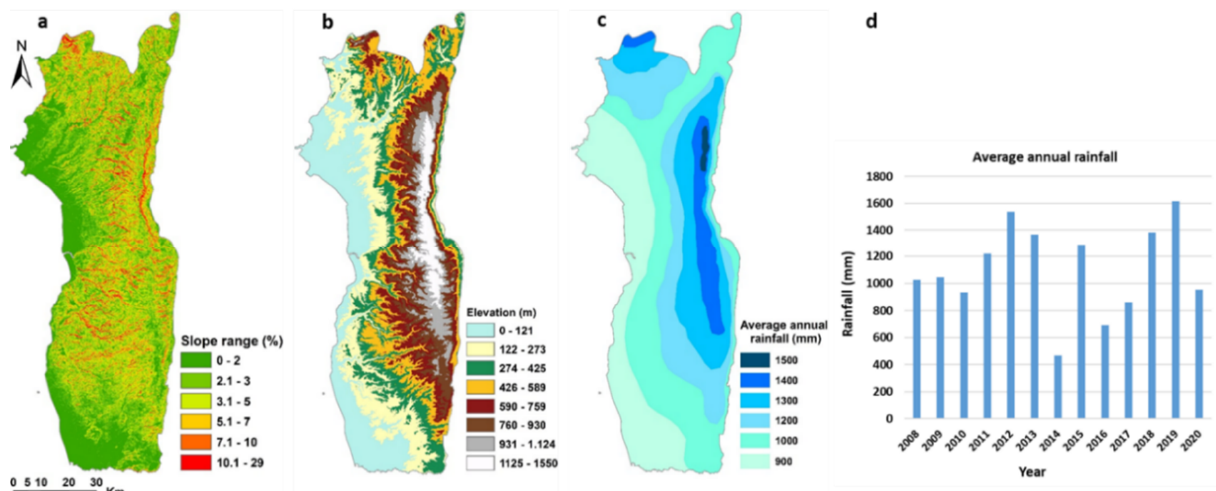
Figure 2. Slope (in %) derived from Advanced Spaceborne Thermal Emission and Reflection Radiometer (ASTER)-digital elevation model (DEM) [46] ( a ), topographical elevation above sea level in meter [46] ( b ), spatial pattern of average yearly rainfall adapted from [53,54] ( c ), and average annual rainfall between 2008 and 2020 adapted from [53] ( d ).